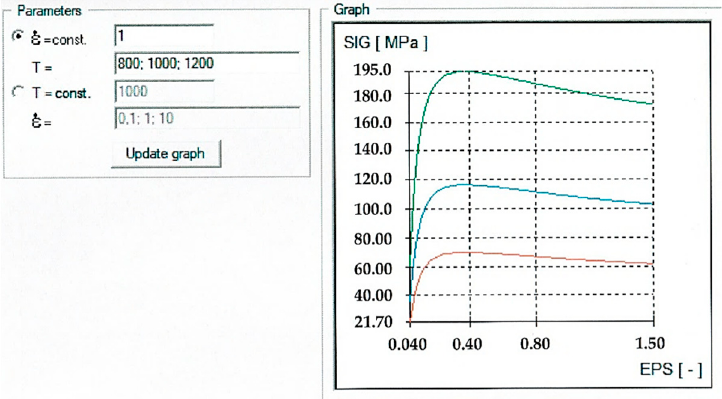
Table 2. Material constants of the 55NiCrMoV7 steel in the Hansel–Spittel model (parameter values were obtained from the approximation of Equation (1).